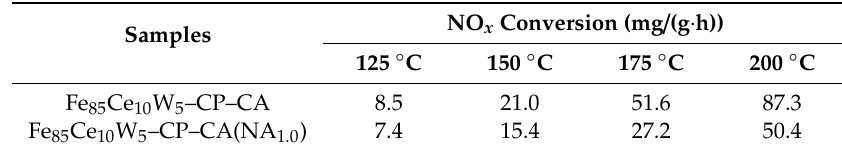
Figure 1. The NO x conversion over the catalyst. Reaction conditions: [NO] = [NH 3 ] = 1000 ppm, [O 2 ] = 3.0 vol.% and 2000 mL/min of total flow rate. A total of 2 mL of catalyst with a gas hourly space velocity (GHSV) of 60,000/h. Table 1. The NO x conversion over per gram of catalysts under a gas hourly space velocity (GHSV) of 60,000/h.